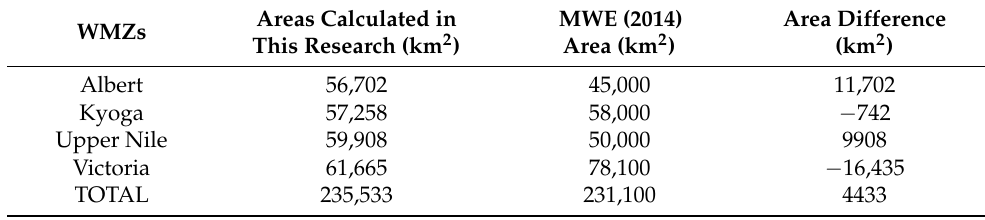
Table 1. Areas of the WMZs in